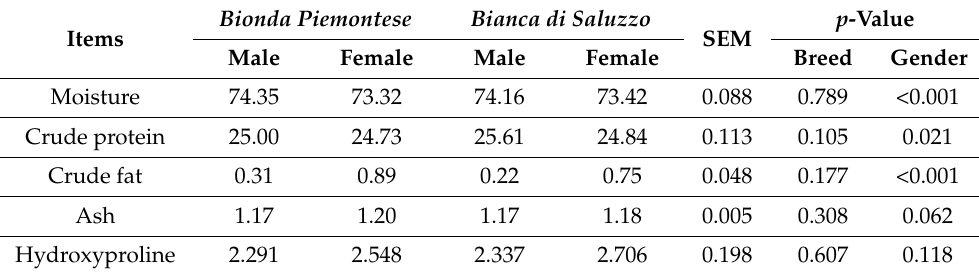
Table 4. Average chemical composition (g/100 g FM) and hydroxyproline content (mg/g dry weight) of breast meat of Bionda Piemontese and Bianca di Saluzzo breeds. Data are the average of the four consecutive slaughtering at 5, 6, 7, and 8 months of age ( n =